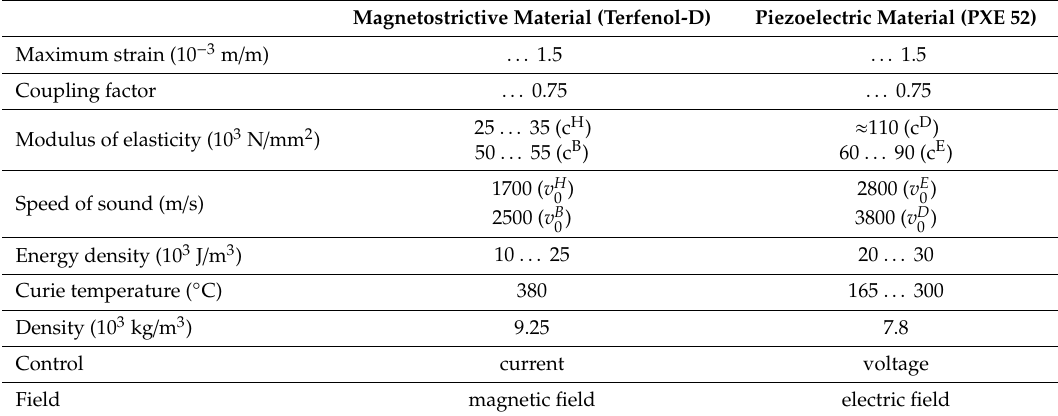
Table 1. Comparison between piezoelectric and magnetostrictive material [18].